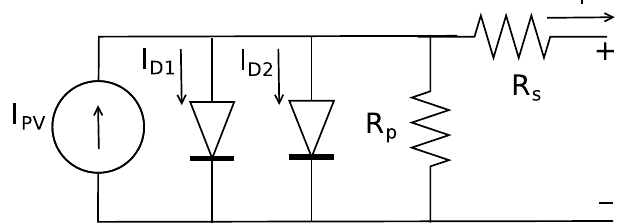
Figure 1. The two diodes equivalent circuit of a photovoltaic (PV)